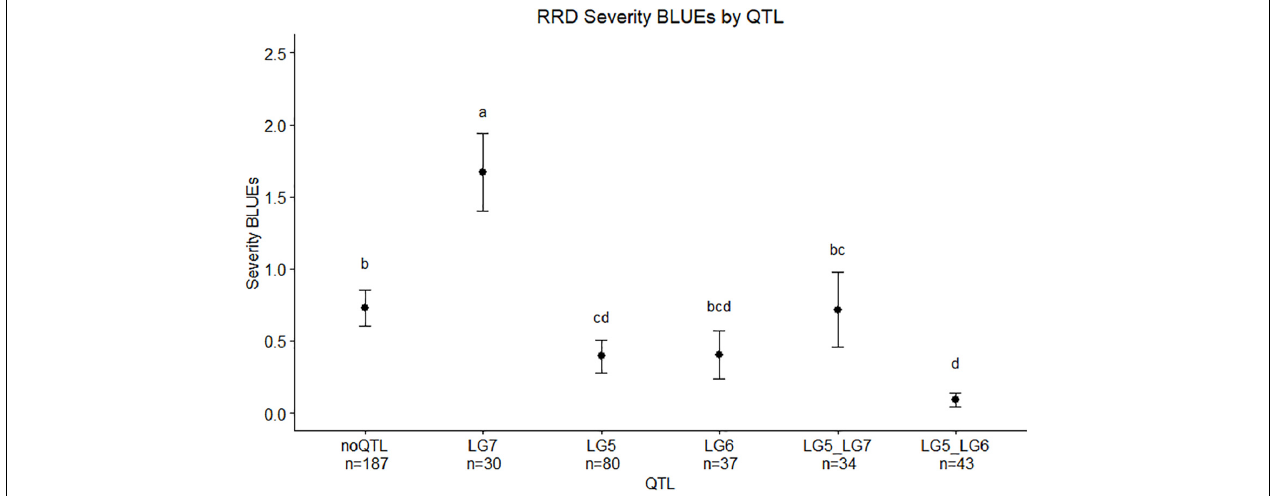
FIGURE 8 | Means separation and 0.95 confidence intervals of RRD severity best linear unbiased estimates (BLUEs) measured in two tetraploid biparental garden rose mapping populations grouped by QTL carried by progeny. Groups with the same letters are not significantly different from each other using Tukey’s test ( α = 0.05). Individuals shown in this study are from r-packages MAPpoly and QTLpoly (note: the sample numbers depicted in this study represent only the individuals that were